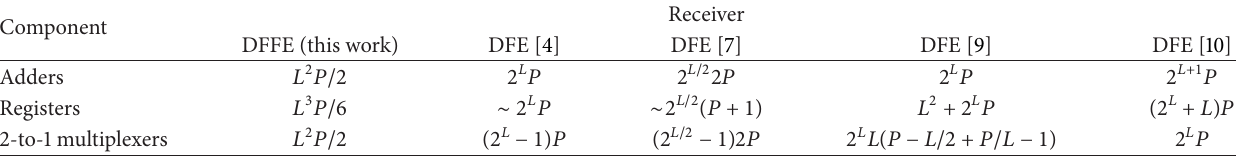
Table 2: Complexity comparison between parallel DFFE and DFE architectures for 2 -PAM with 𝑅 = 𝐿 + 1 for 𝐿 ≫ 1 . Component